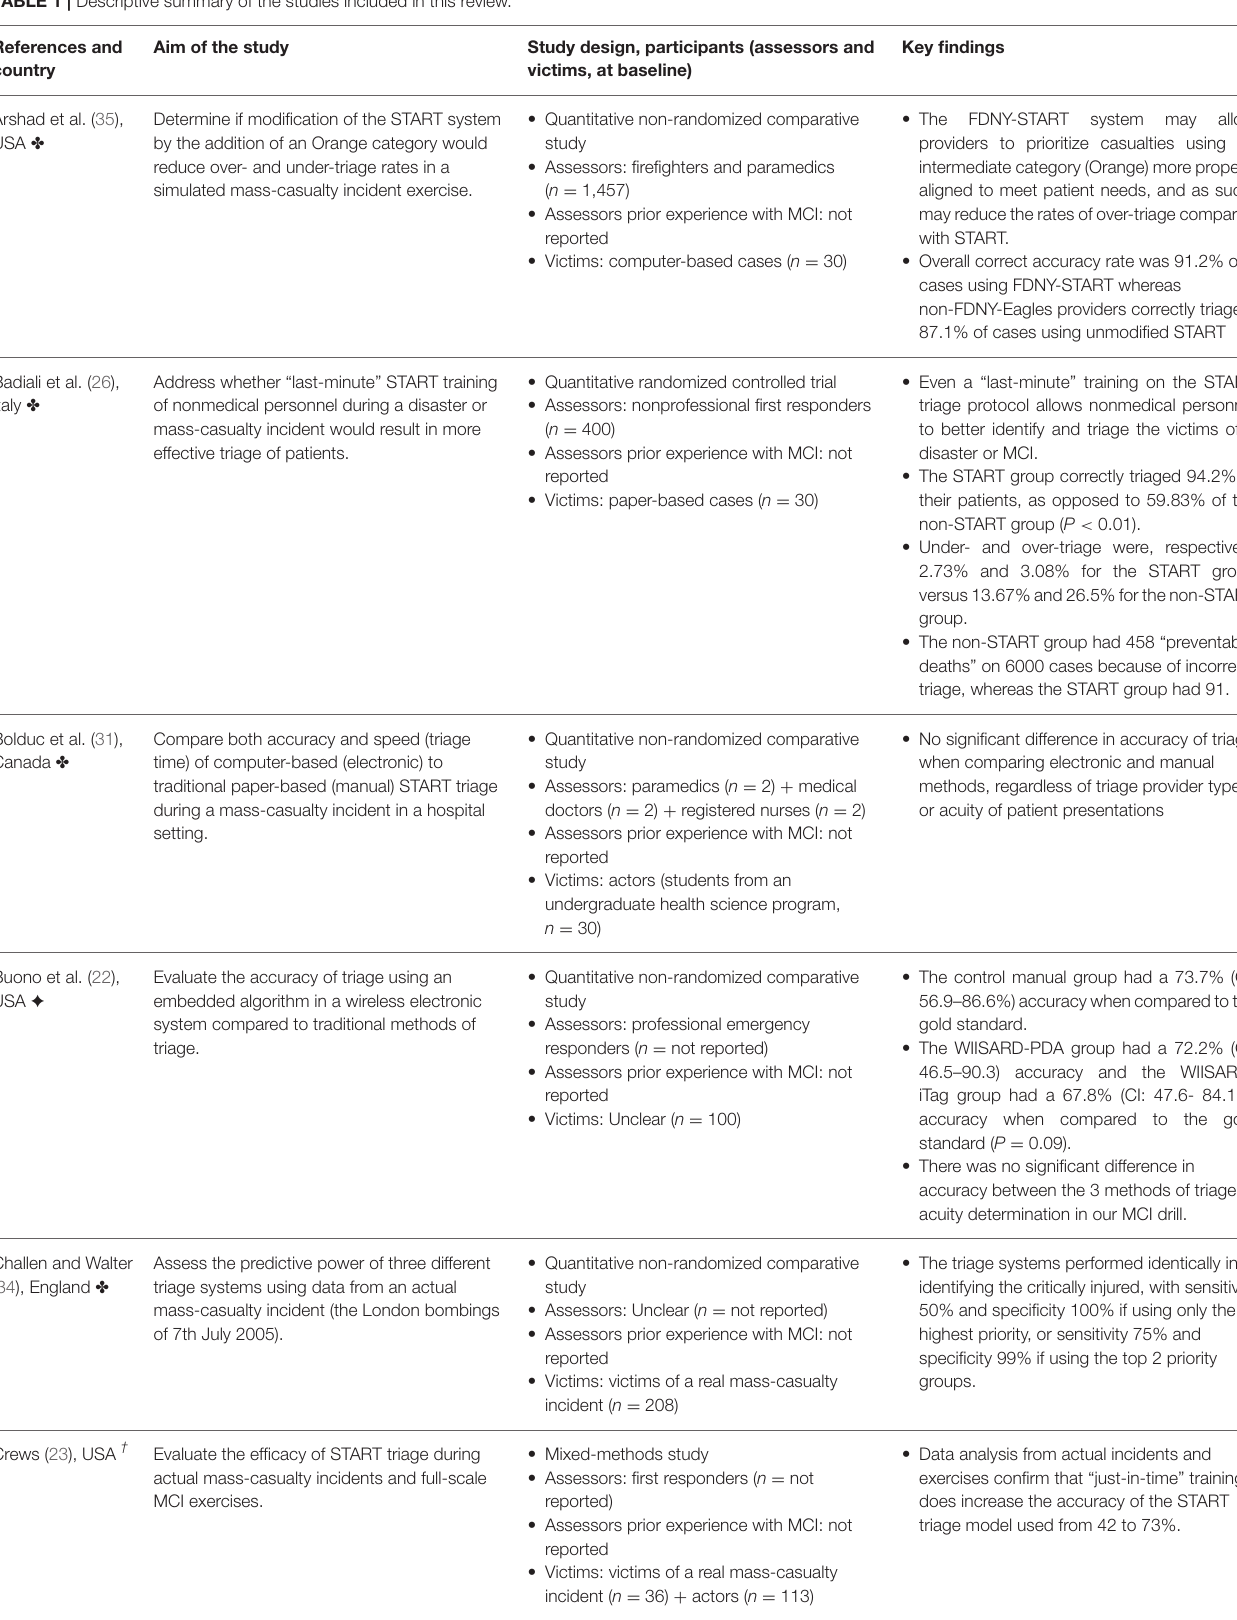
TABLE 1 | Descriptive summary of the studies included in this